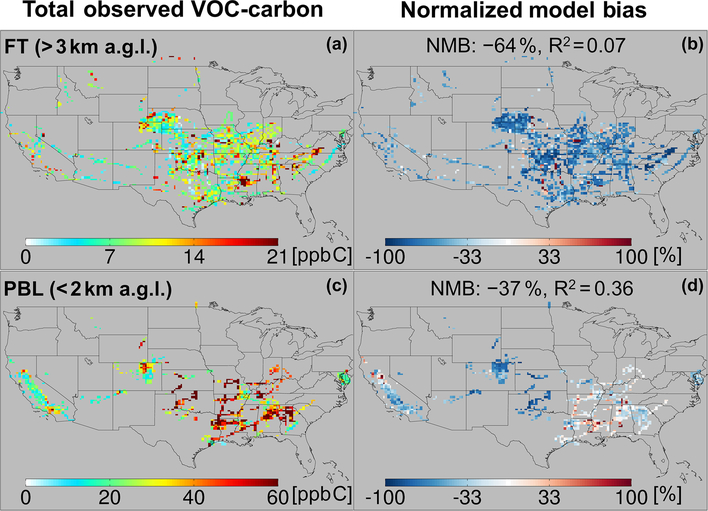
Total observed VOC-carbon loading (a, c) over North America in the free troposphere (> 3 km a.g.l.) and planetary boundary layer (< 2 km a.g.l.). In (b, d) the GEOS-Chem model simulation is compared to co-located aircraft observation with the normalized mean bias given inset. Note that the sampling season and instrument payload vary among campaigns.